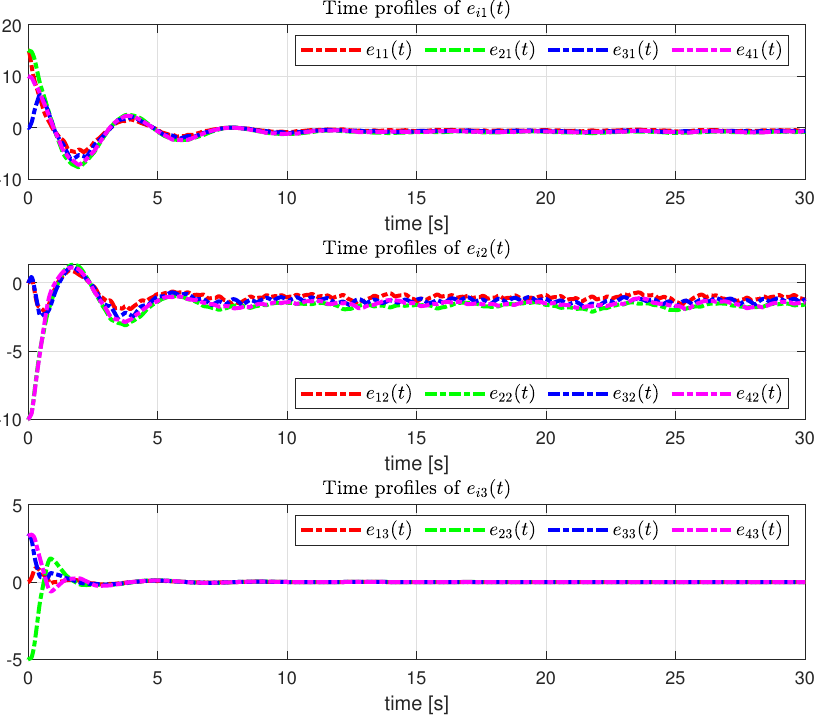
Figure 10. Performance of the control method in [29] under communication network ¯ T c = 0.1